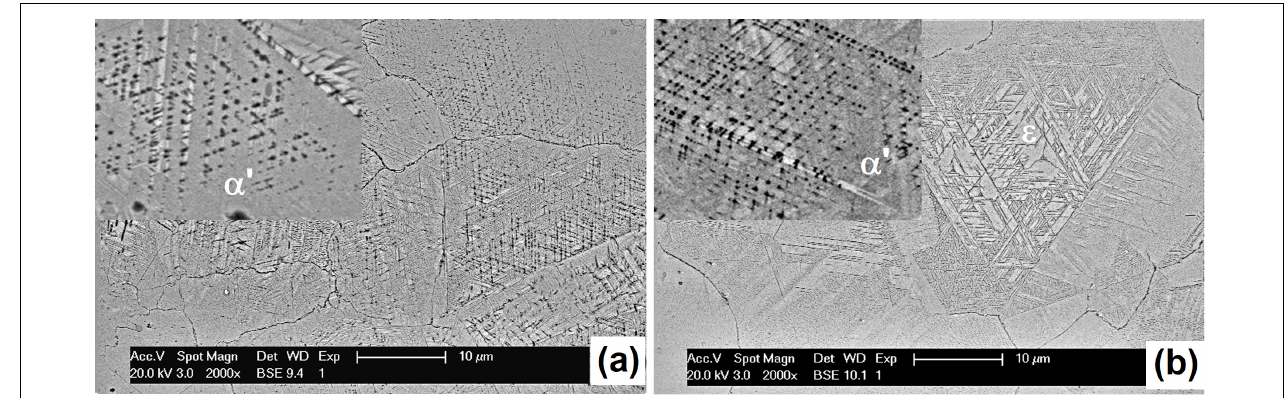
FIGURE 10 | Influence of MA degree on the microstructure of specimens pre-strained with 4%: (a) 0_MA_1100 and (b) 50_MA_1100, with thermally induced ε -hcp martensite. The insets display the effects of 4% pre-straining on stress-induced formation of α (cid:48) -bcc martensite (modified after Pricop et al., 2013).